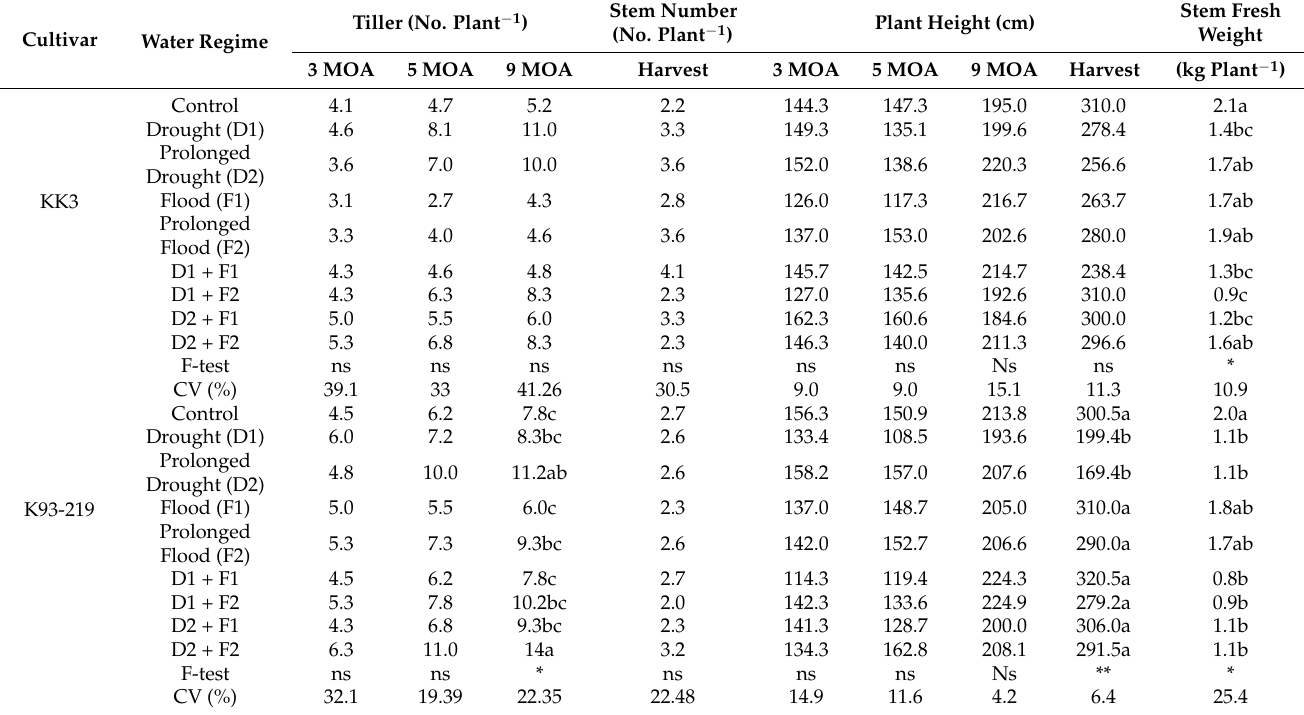
Table 5. Shoot growth parameters of two sugarcane cultivars as affected by drought, flood, and combined treatment, Experiment 1.